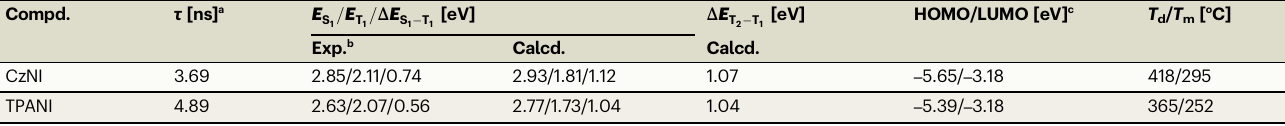
Table 1 | Photophysical, electrochemical, and thermal stability properties of CzNI and TPANI